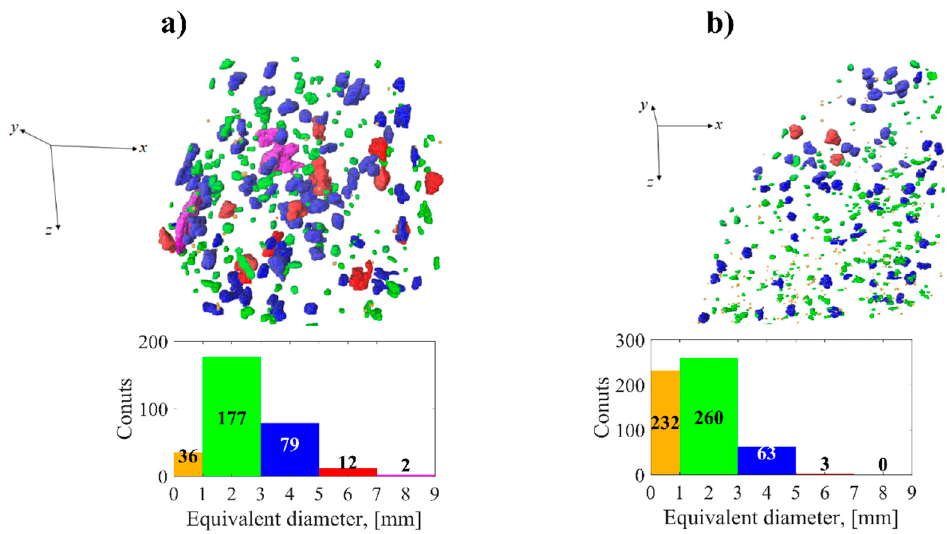
Figure 5. Spatial and size distributions of the segmented inclusions in Sample_1 ( a ) and Sample_2 ( b ). Particles in the 3D models are colored according to the histograms below.